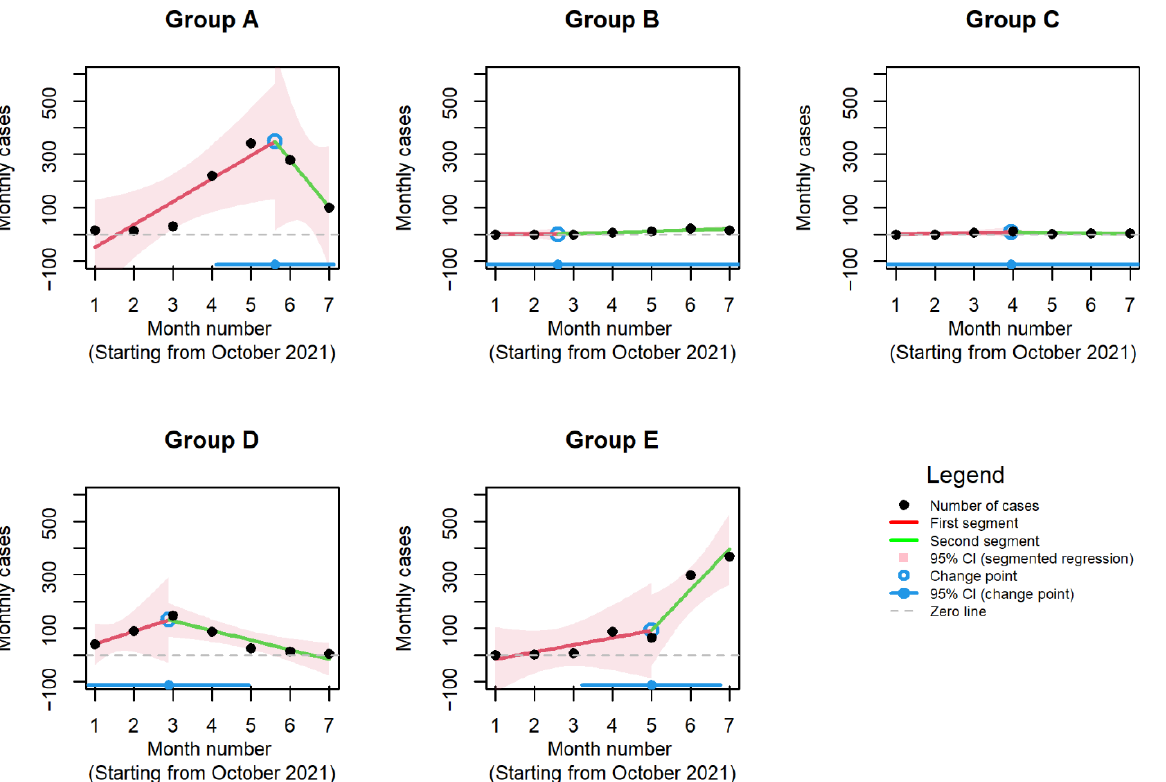
Figure 4. Results of segmented regression (Groups A–E). Group A: SARS-CoV-2; Group B: SARS-CoV-2 and influenza A/B; Group C: SARS-CoV-2 and RSV; Group D: RSV; Group E: influenza A/B.